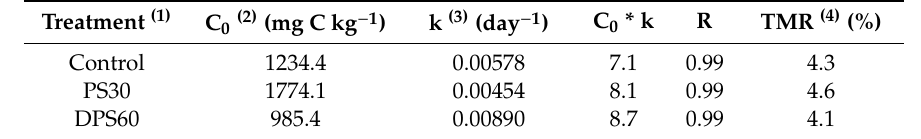
Table 4. Kinetic parameters of carbon (C) mineralization according to the exponential model calculated